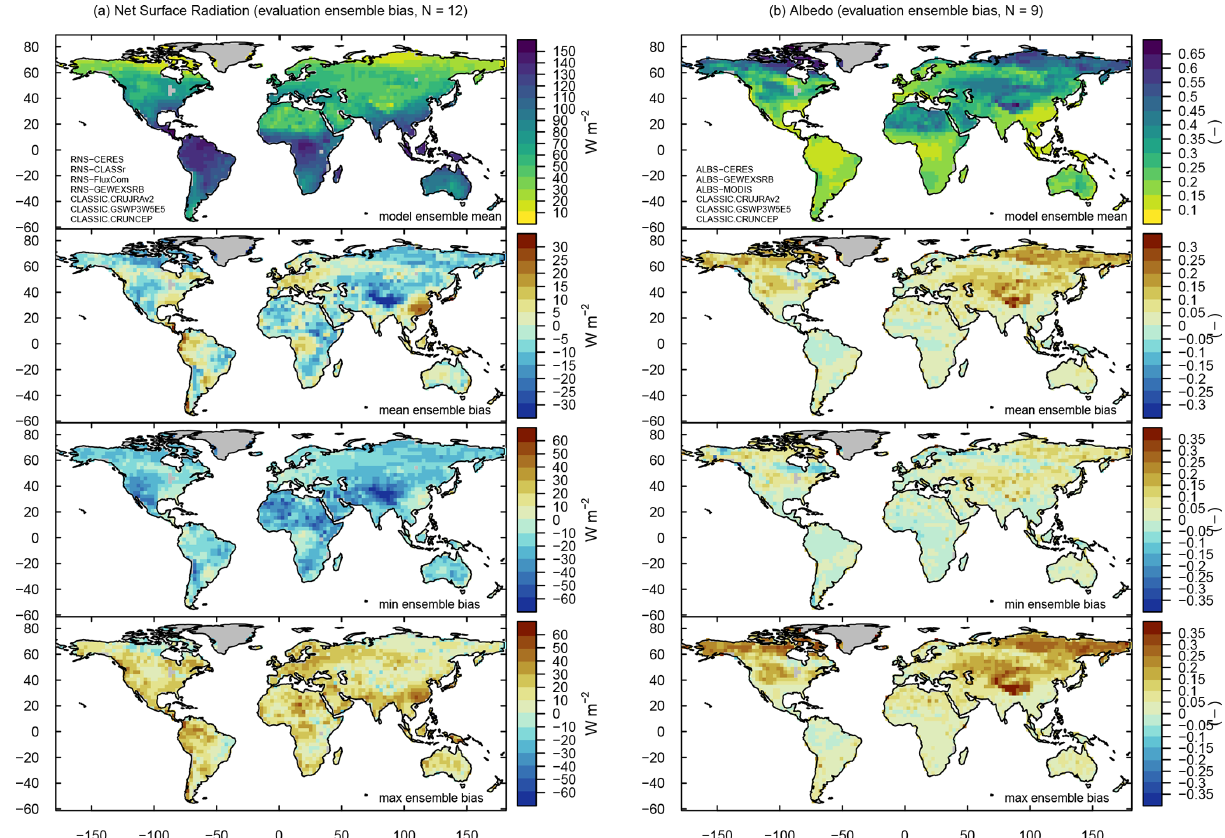
Figure 7. Model ensemble mean values and respective biases for (a) net surface radiation and (b) surface albedo. The mean, minimum, and maximum ensemble biases refer to the mean, minimum, and maximum values across all evaluations, respectively. For instance, a minimum bias that is negative implies that at least one evaluation yields a negative